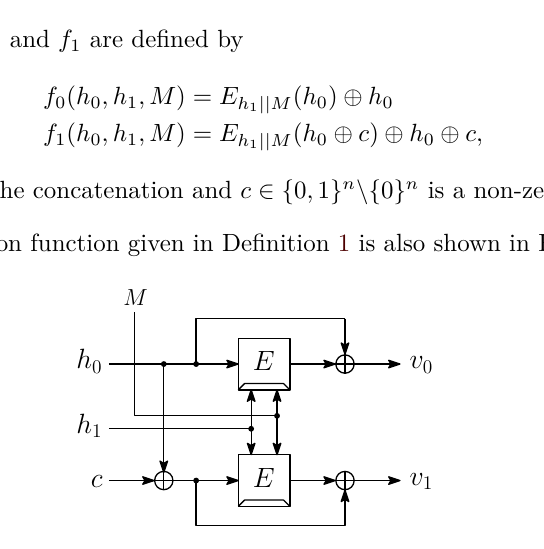
Figure 2: Hirose’s double block length compression function CF